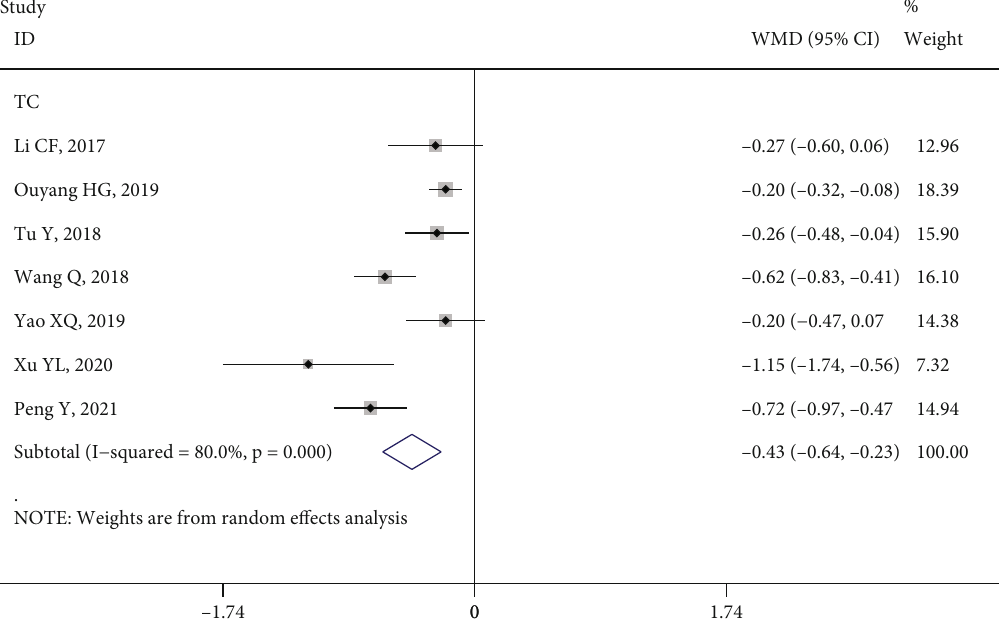
Figure 5: Forest plot of the e ff ect of health literacy intervention on